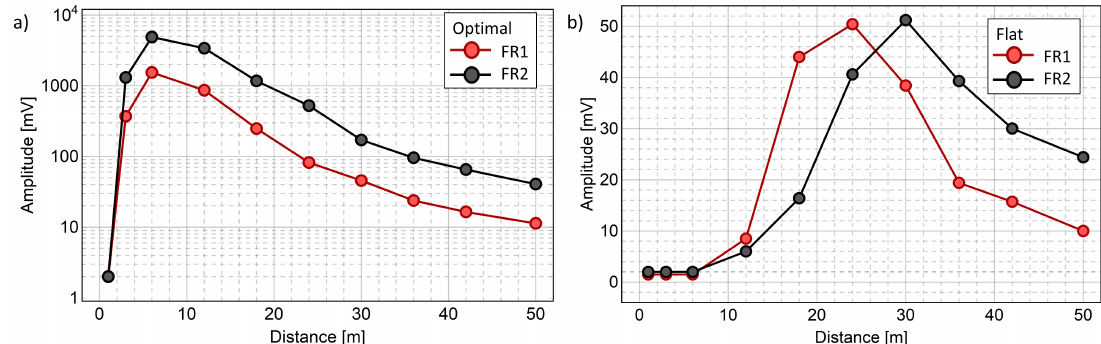
Figure 3. Amplitude of received signal as a function of distance for two optical lenses ( FR 1 and FR 2) and two receiver positions, ( a ) shows the Optimal configuration in which receiver is always pointing towards the transmitter, and ( b ) shows the Flat case where the optical axis of the receiver is parallel to the floor.